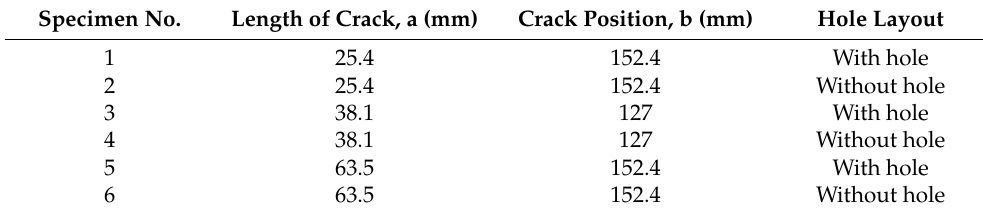
Figure 1. Geometry of the three-point bending beams: with holes ( left ), without holes ( right ). Table 1. Configurations of the three-point bending beam specimen. Specimen